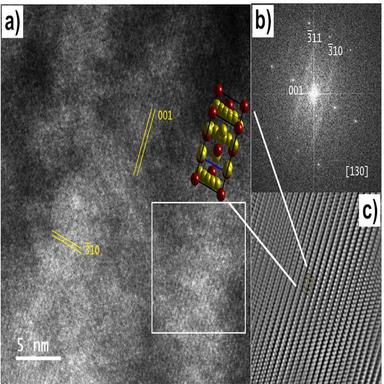
a) HRTEM image obtained on a Fe2Al5 grain, together with the FFT (b) and inverse FFT (c) of the area enclosed in the white box.